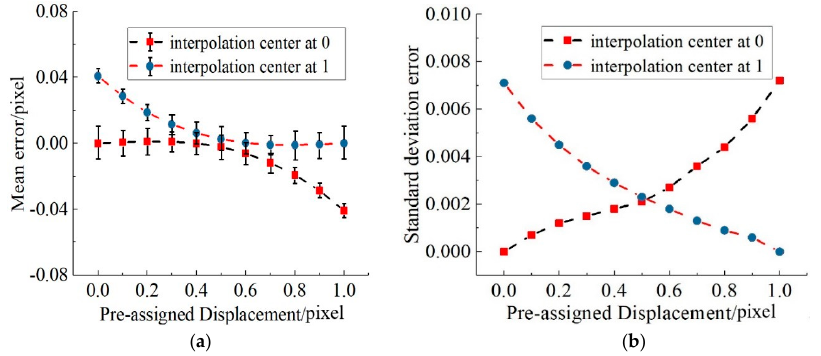
Figure 4. Matching error without noise: ( a ) mean error; ( b ) standard deviation error.